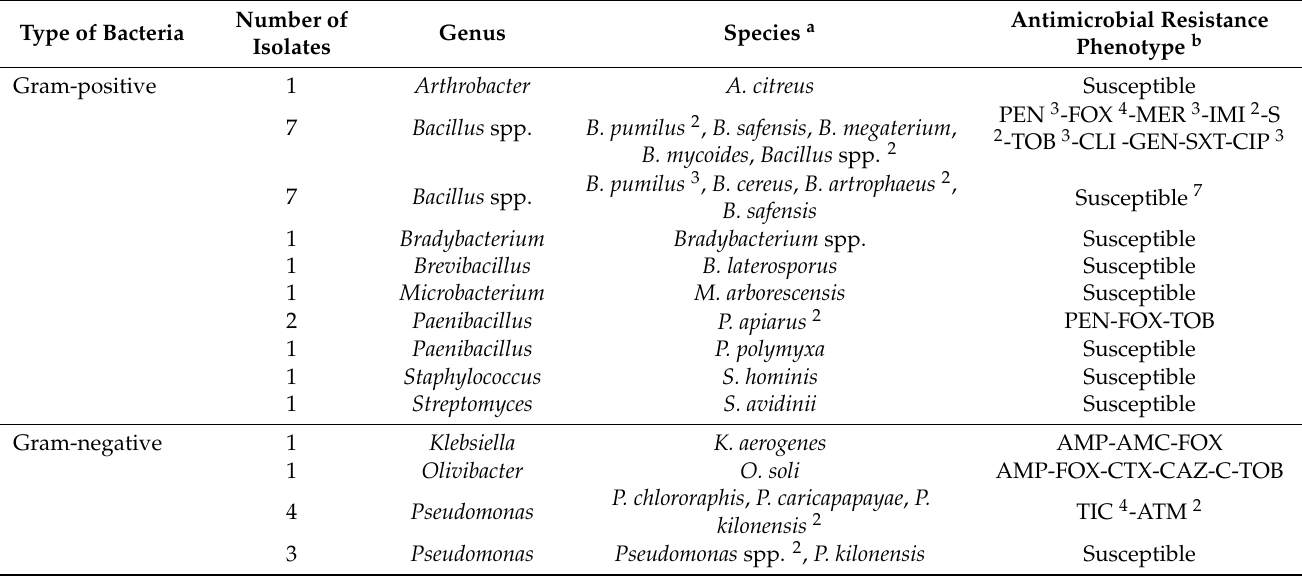
Table 4. Antimicrobial resistance phenotype of the selected 32 antimicrobial-producing isolates obtained in the second